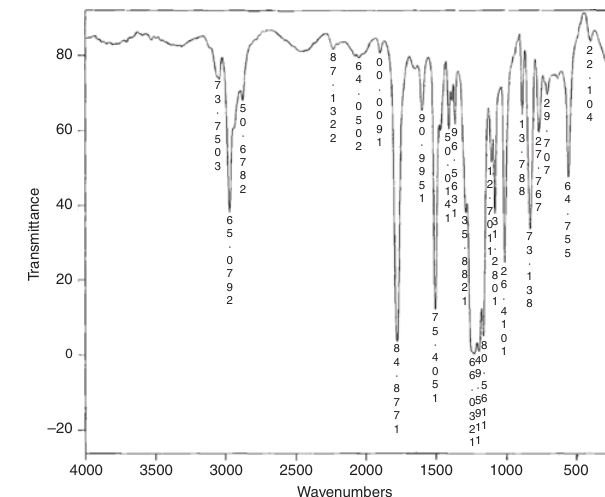
Figure 11: FT-IR spectrum of the PC-SrFe nanocomposite.